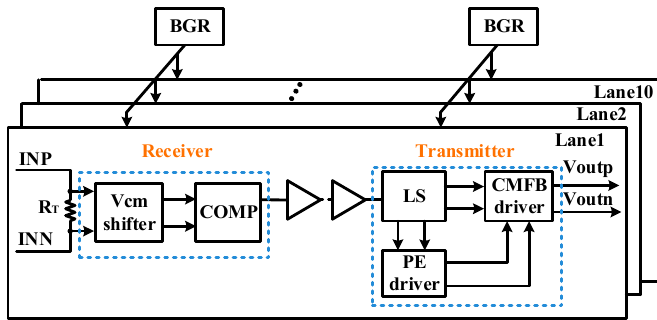
Figure 3. Simplistic circuit of 10-lane LVDS transceiver.